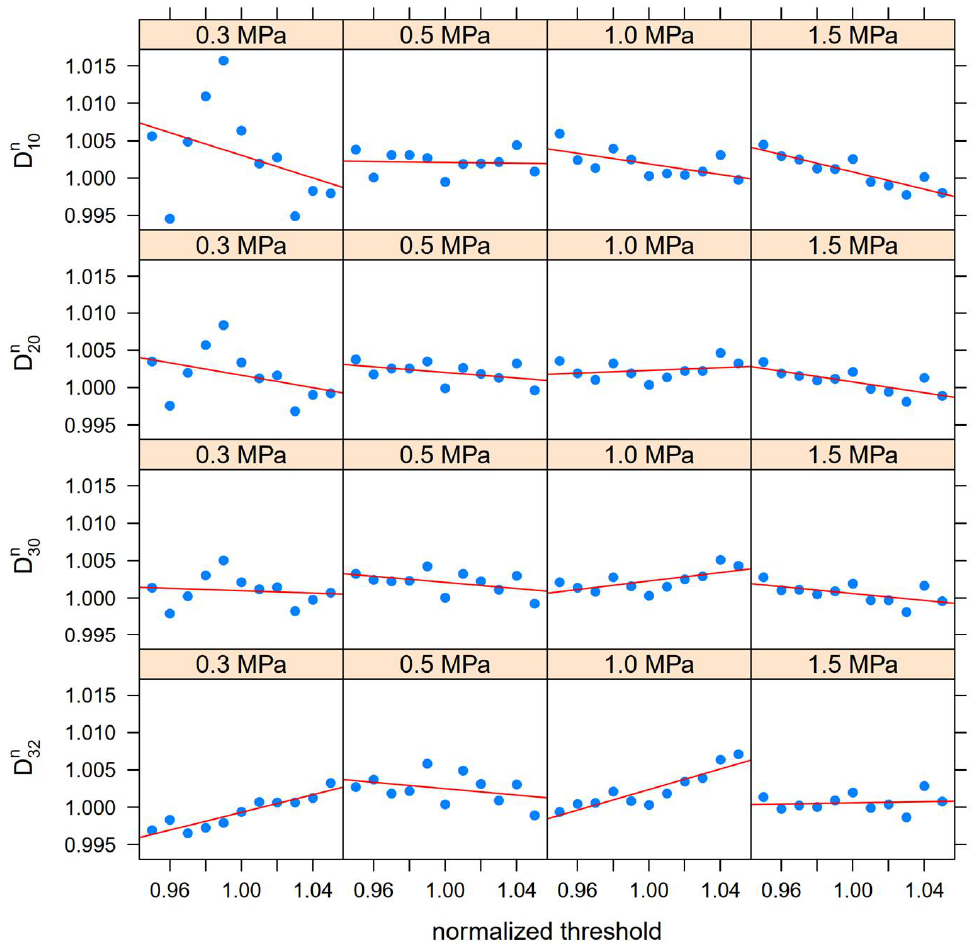
Figure 8. Variations in normalized arithmetic, surface, volume, and Sauter mean diameters with respect to the normalized threshold.